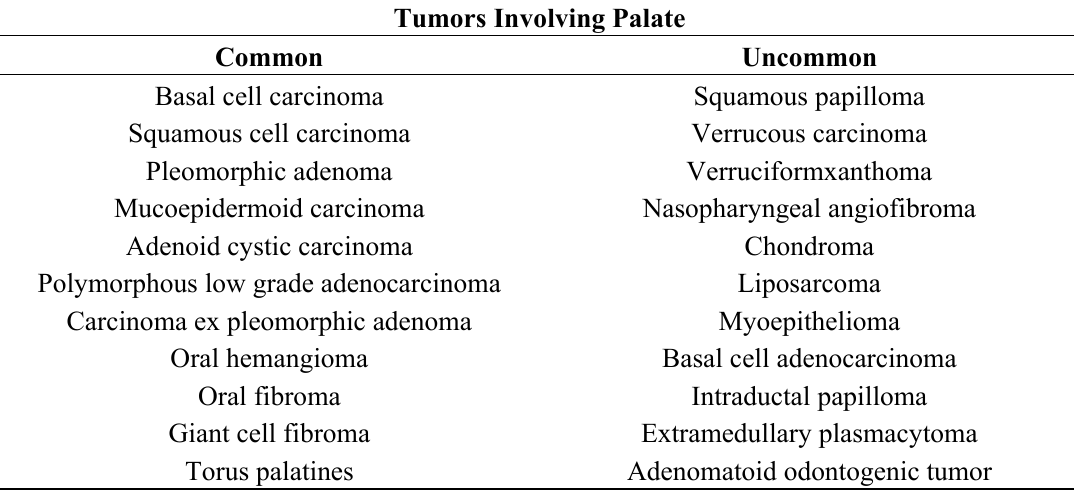
Table 1. A proposed list of tumors involving